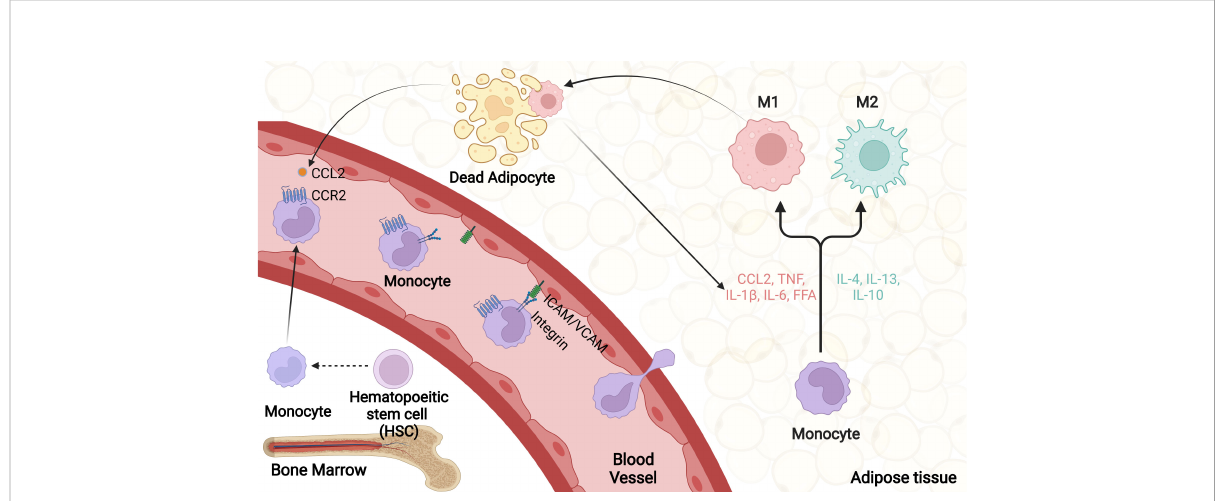
FIGURE 2 ATM recruitment. Obesity promotes adipocyte death as well as adipose tissue in fl ammation, which fi rstly trigger a large number of chemokines secretion, including CCL2. Upon activation, monocytes and vascular endothelial cells produce various cellular adhesion molecules, mainly integrin, ICAM-1 and VCAM-1. Through rolling and adhesion process, monocytes bind to adhesion molecules on vascular endothelial cells and transmigrate from blood vessel to target adipose tissue. Eventually, recruited monocytes differentiate into proin fl ammatory macrophages in response to local microenvironmental